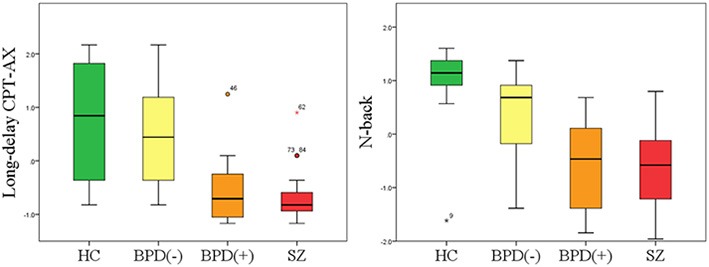
Neurocognitive performance in HC, BPD(−), BPD(+) and SZ patients on D Long-delay CPT-AX and N-back tasks. Results are converted to Z-scores for better visualization. Box plots are shown with 95% CI as error bars. Abbreviations: HC, healthy controls; SZ, schizophrenia; BPD(−), bipolar disorder without history of psychosis; BPD(+), bipolar disorder with history of psychosis.